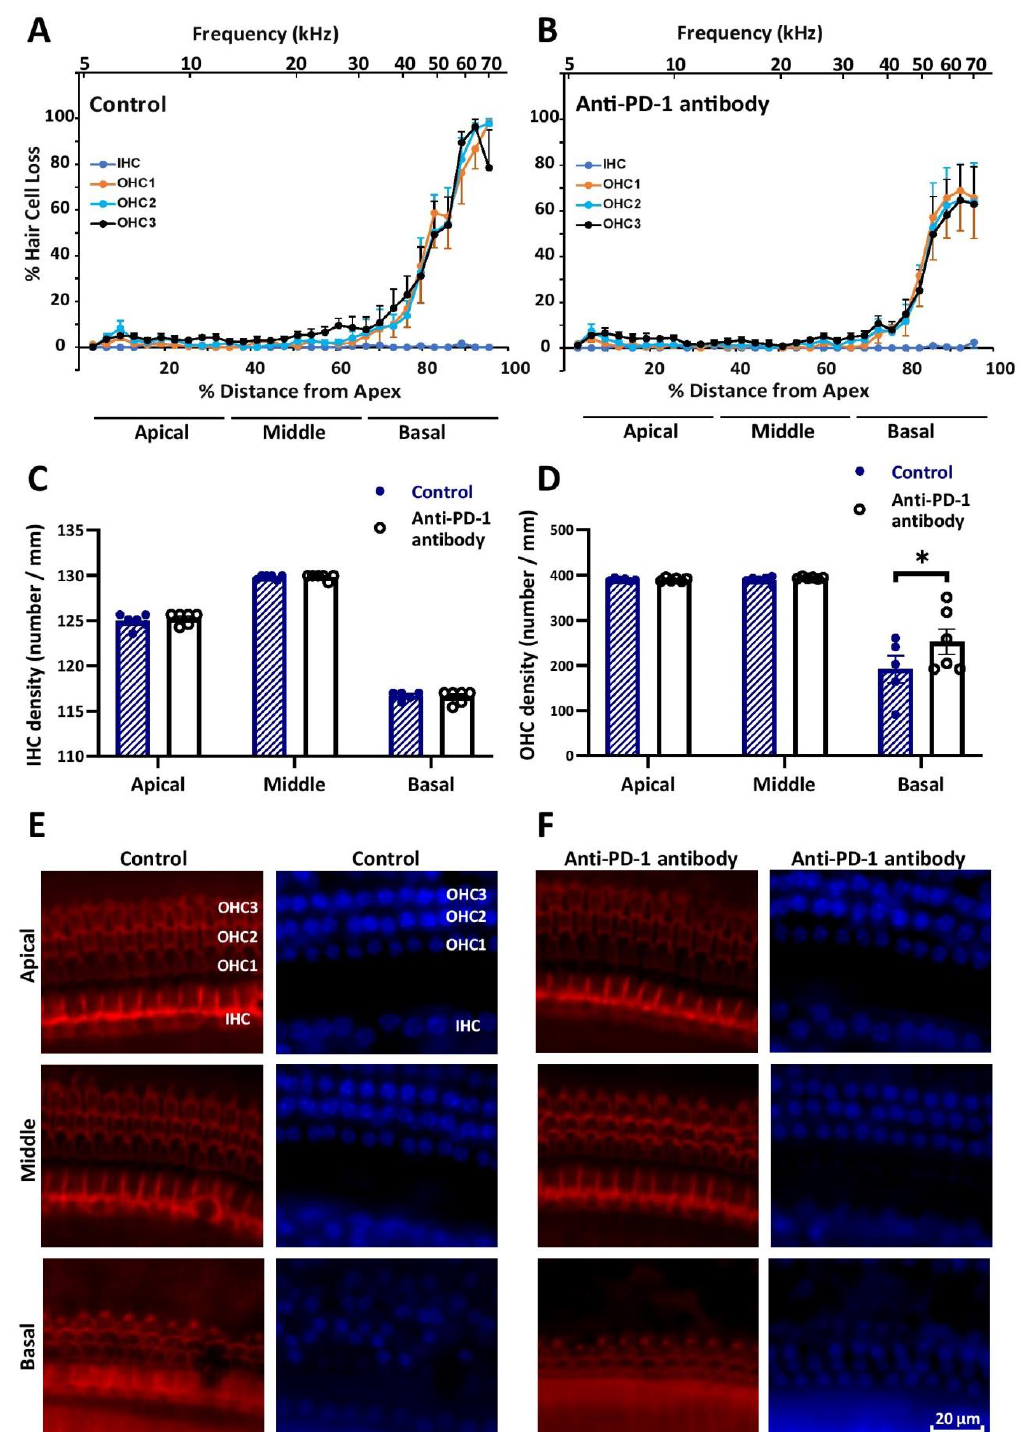
Figure 2. Anti-PD-1 antibody treatment did not change the number of hair cells in the apical and middle turns, but mitigated the loss of outer hair cells (OHCs) in the basal cochlear turns in C57BL / 6J mice. Cytocochleograms of the control ( A ) and the anti-PD-1 antibody treated ( B ) group ( n = 6–6) show the lack of inner hair cell (IHC) and OHC loss in the whole length of the cochlear duct and in the < 32 kHz range, respectively. The loss of OHCs in the high-frequency basal turn was less prominent in the anti-PD-1 antibody-treated group. Bar graphs of inner ( C ) and outer ( D ) hair cell densities in the three cochlear segments demonstrate the significant di ff erence in OHC in the basal turn. ( E , F )